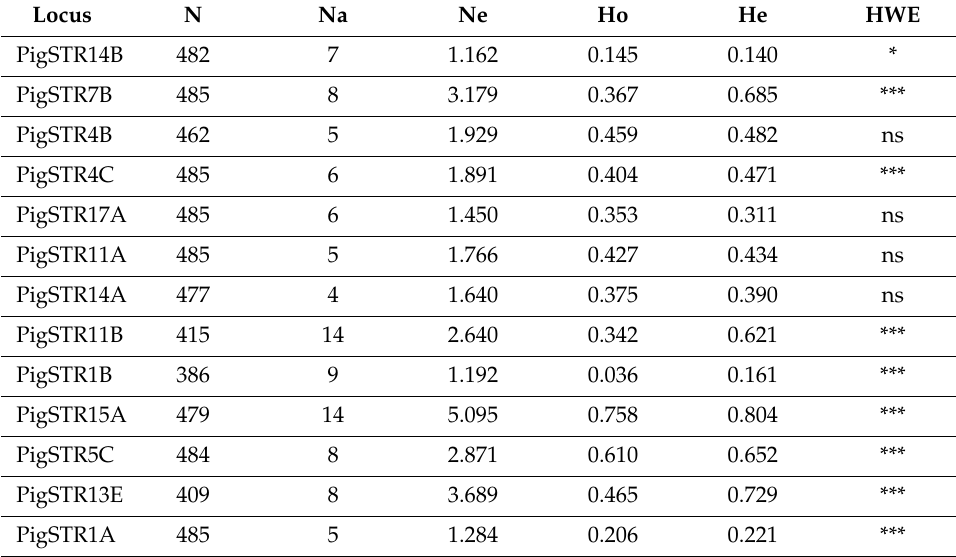
Table 1. Genetic diversity found in the Hungarian wild boars studied. Locus